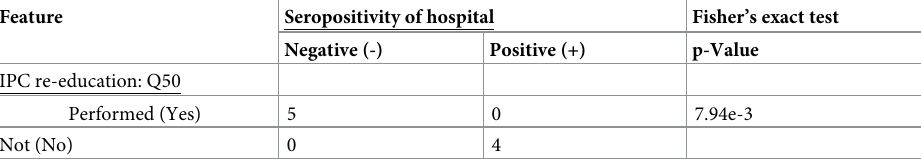
Table 4. Institutional comparison for SARS-CoV-2 seropositivity of